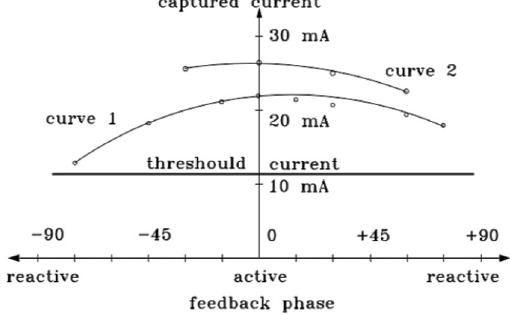
FIG. 1. Single-bunch beam current injected in VEPP-4M as a function of the feedback